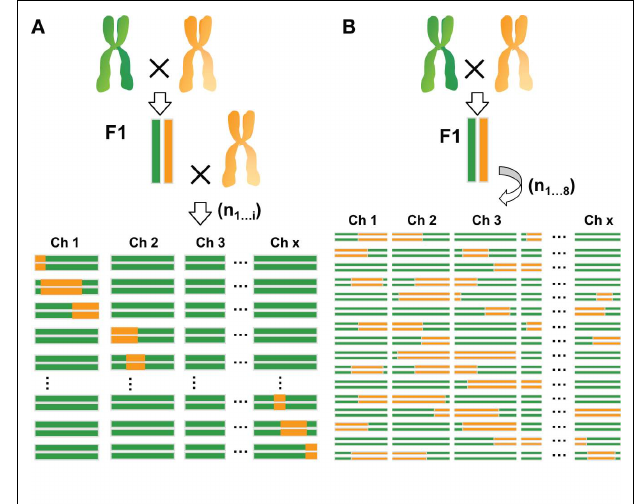
FIGURE 1 | Comparison of introgression (A) and recombinant inbred lines (B). Introgression lines are created by backcrossing an F1 of a cross between two parental lines to a recurrent parent for several times. Homozygous individuals containing single introgressions are then selected from the progeny. Recombinant inbred lines are generated by selfing an F1 for at least eight generations when full homozygosity is reached. Each individual of the population contains multiple introgressions. Recombinant inbred lines allow for the testing of epistasis. Also because of the higher recombination frequency they often offer higher resolution than introgression lines. Introgression lines, however, often display greater statistical power in the detection of small-effect